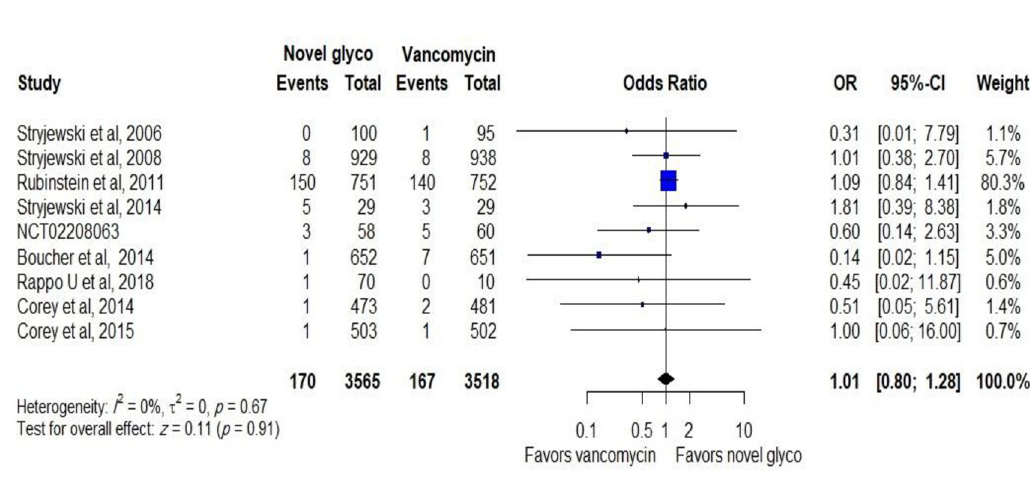
Fig 7. Discontinuation of novel glycopeptides against vancomycin due to adverse events in the modified intent-to-treat population.